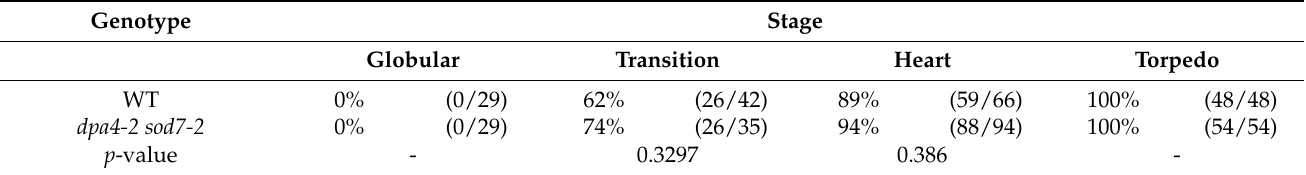
Table 1. Frequency of CLV3 expression in embryos depending on the developmental stage and the genotype.